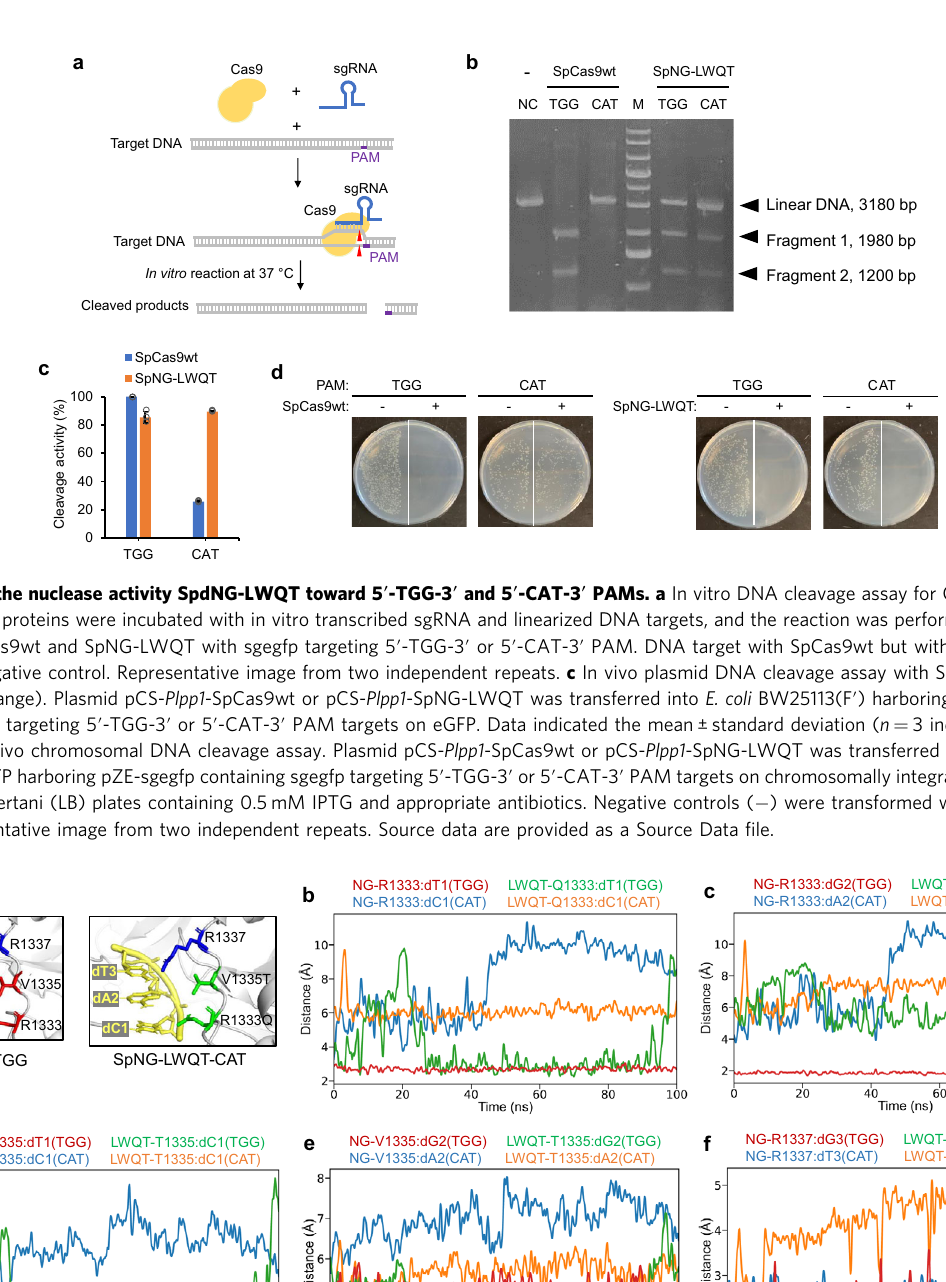
Q1333 (or T1335) and dT1 (or dG2) on SpNG-LWQT-TGG are similar or even shorter compared to the distance between R1333 (or V1335) and dT1 (or dG2) (Fig. 4b, d, e). For R1337 and dG3, the minimum distance on SpNG-LWQT-TGG is shorter than that on SpNG-TGG (Fig. 4f). These results showed that SpNG-LWQT can interact with not only 5 ′ -TGG-3 ′ PAM but also 5 ′ -CAT-3 ′ PAM, suggesting that the ability of Cas9 to interact with diverse PAM sequences is improved.